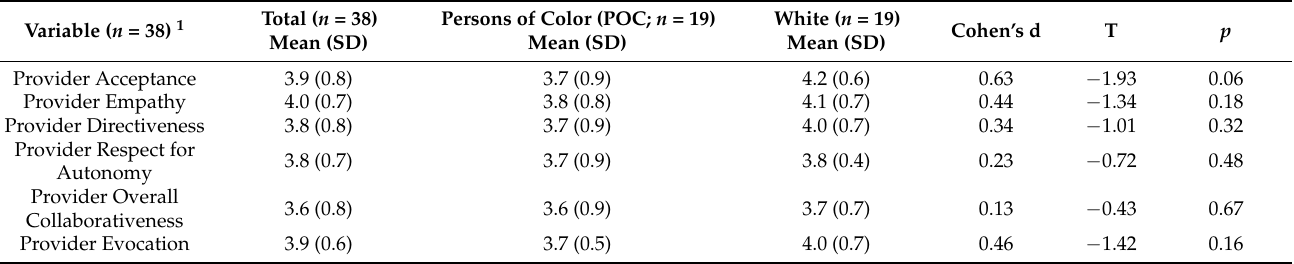
Table 2. MISC Global